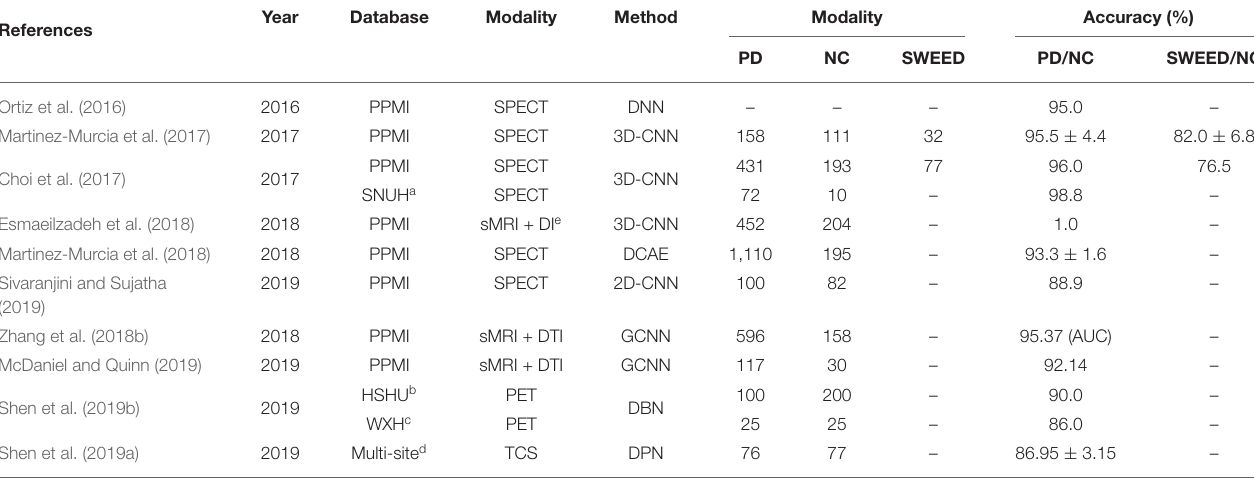
TABLE 5 | Overview of papers using deep learning techniques for PD